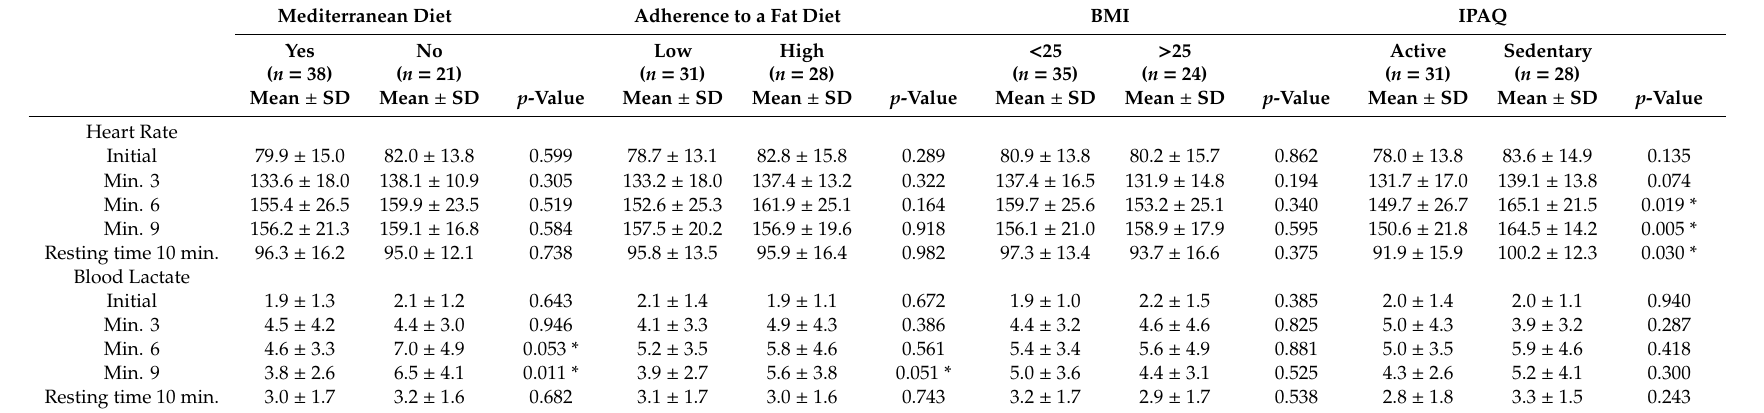
Table 2. Physiological parameters (heart rate / blood lactate) according to the dietary habits and lifestyle of the participants (Mediterranean diet, adherence to a fat diet, BMI, International Physical Activity Questionnaire